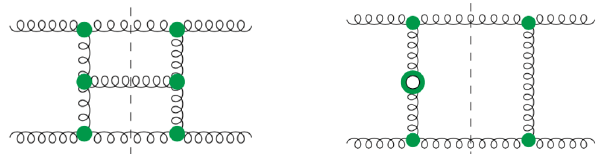
Figure 2 . ( a ) Tree five-gluon amplitude. The green blob along the gluon ladder represents the central-emission vertex. ( b ) Regge trajectory in the one-loop four-gluon amplitude. The pierced blob represents the one-loop Regge